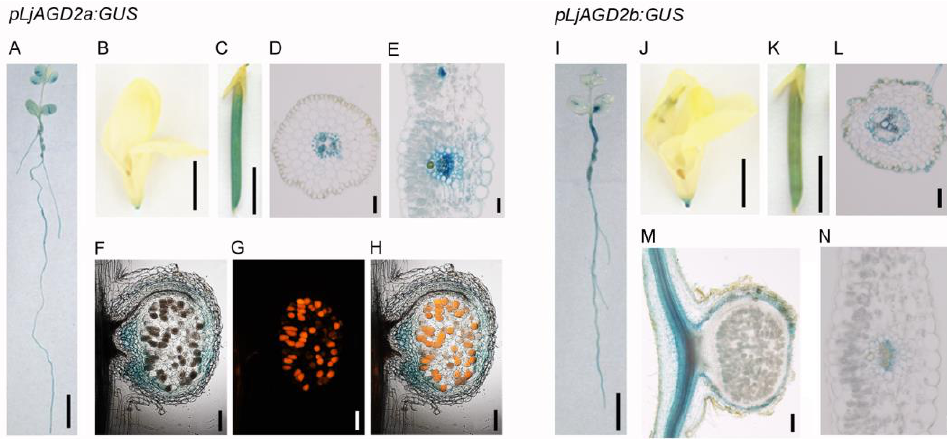
Figure 1. Expression pattern of LjAGD2s in L. japonicus . ( A – H ) GUS histochemical staining of pLjAGD2a:GUS plants. ( A ) GUS histochemical staining of a 2-week-old pLjAGD2a:GUS seedling. ( B ) GUS staining of a flower of a pLjAGD2a:GUS plant. ( C ) GUS staining of a pod of a pLjAGD2a:GUS plant. ( D ) Section of a root of a 2-week-old pLjAGD2a:GUS plant. ( E ) Section of a leaf of a 2-month-old pLjAGD2a:GUS plant. ( F – H ) Section of a nodule of a pLjAGD2a:GUS plant 2 weeks after inoculation with Mesorhizobium loti expressing DsRED . GUS histochemical staining of the nodule in ( F ), Bacteriods in the infection cells expressing red fluorescence in ( G ), Overlap of F and G images in ( H ). ( I – N ) Histochemical staining of pLjAGD2b:GUS plants. ( I ) GUS histochemical staining of a 2-week-old pLjAGD2b:GUS seedling. ( J ) GUS staining of a flower of a pLjAGD2b:GUS plant. ( K ) GUS staining of a pod of a pLjAGD2b:GUS plant. ( L ) Section of a root of a 2-week-old pLjAGD2b:GUS plant. ( M ) Section of a nodule of a 2-week-old pLjAGD2b:GUS plant inoculated with M. loti . ( N ) Section of a leaf of a 2-month-old pLjAGD2b:GUS plant. Sixty seedlings were subjected to GUS staining as illustrated in ( A , I ), with more than 90% showing the phenotype. Flowers and pods collected from more than 10 individual plants were used for the GUS staining illustrated in ( B , C , J , K ). For sections, more than six samples were used.